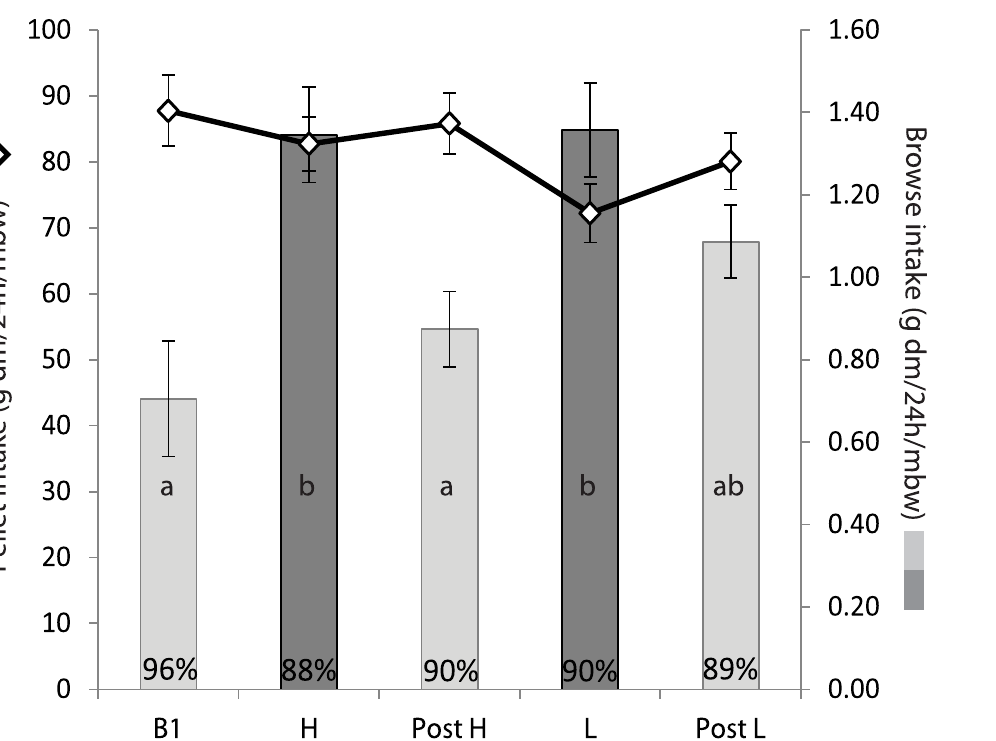
Fig 2. Mean intake of pellets (diamonds, y 1 ) and browse (bars, y 2 ) by adult moose; for each of the five experimental phases (high protein (H), low protein (L), Buffet 1, Post H buffet, Post L buffet). Variation among days and individuals is indicated by ± 1 SE. Intake of browse during no-choice treatments (H and L) is indicated with dark grey bars and compared to browse intake during buffets (light grey bars); statistical results regarding browse are indicated by letters within bars (see also Table 4). Values at bottom of bars show the percentage of the browse intake that was made up by fine twigs, the remainder being coarse twigs and